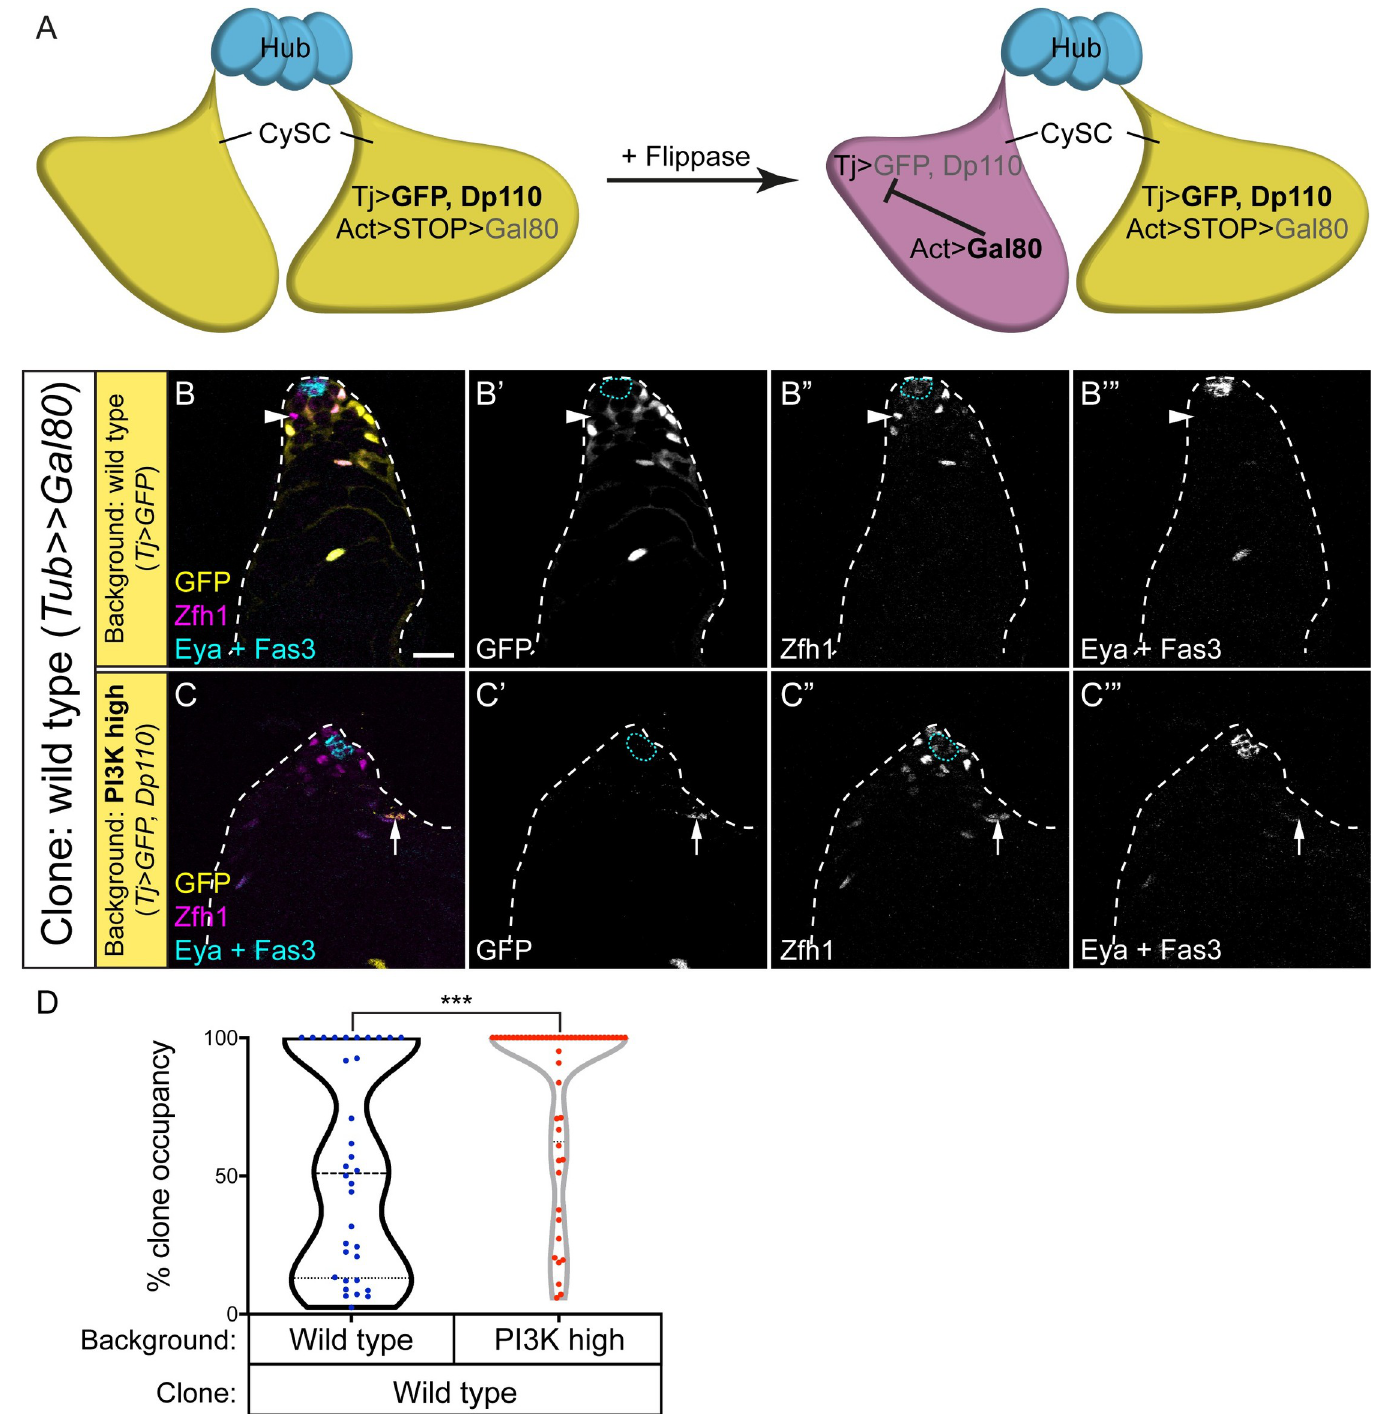
Fig 5. Differences in neighbour PI3K activity levels influences the niche occupancy of wild type clones. A. Schematic explaining the genotypes of clones and background. All CySCs express GFP (yellow) and Dp110 under tj-Gal4 control while a flipout cassette with an Actin promoter driving Gal80 expression is inactive due to a STOP sequence. Flippase induction excises the STOP cassette, resulting in Gal80 expression which inhibits the activity of Gal4. The resulting cell (magenta) is GFP- negative and does not over-express Dp110. B,C. Wild type Gal80-expressing clones were generated in the cyst lineage that lacked GFP (yellow, single channels in B’,C’). CySCs were labelled with Zfh1 (magenta, single channels in B”,C”), and the hub and cyst cells with Fas3 and Eya respectively (white, single channels in B”’,C”’). B. At 14 dpci, wild type CySC clones (arrowhead) were observed surrounded by GFP-expressing CySCs. C. When GFP-expressing cells also had high PI3K activity, wild type